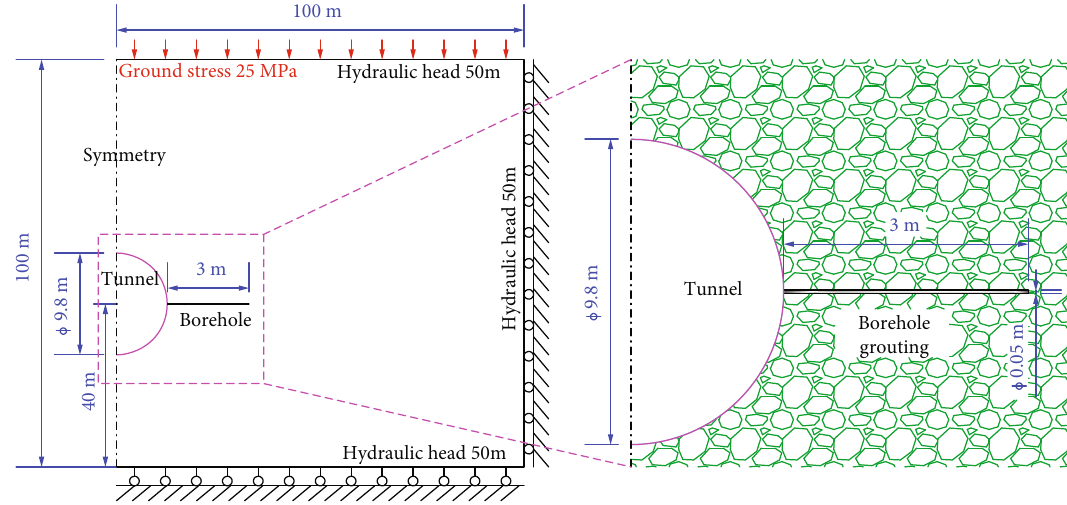
Figure 4: Schematic diagram of the numerical